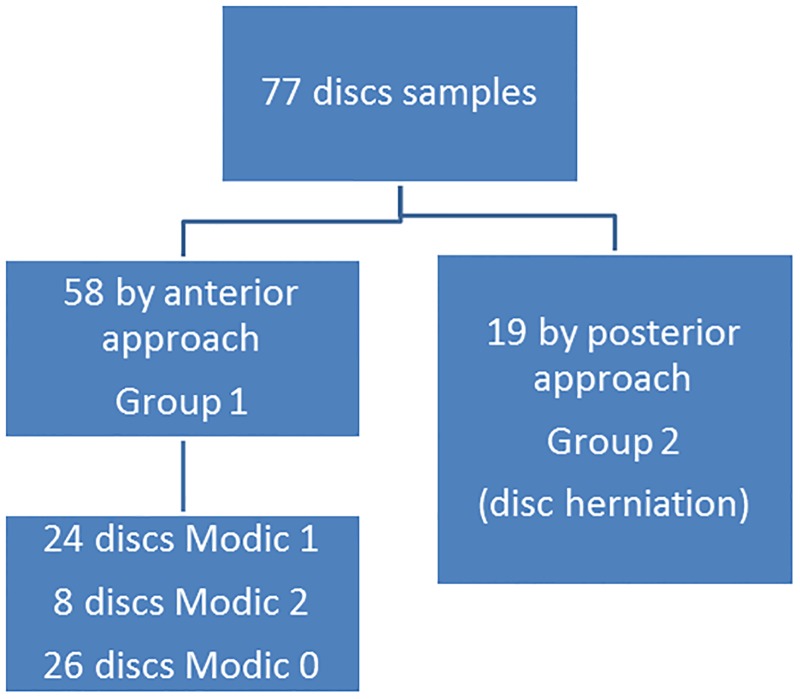
Study flow chart including the type of surgical approach and the underlying disease.From 45 patients, 77 disc samples were obtained: 58 from a anterior and 19 from a posterior approach.